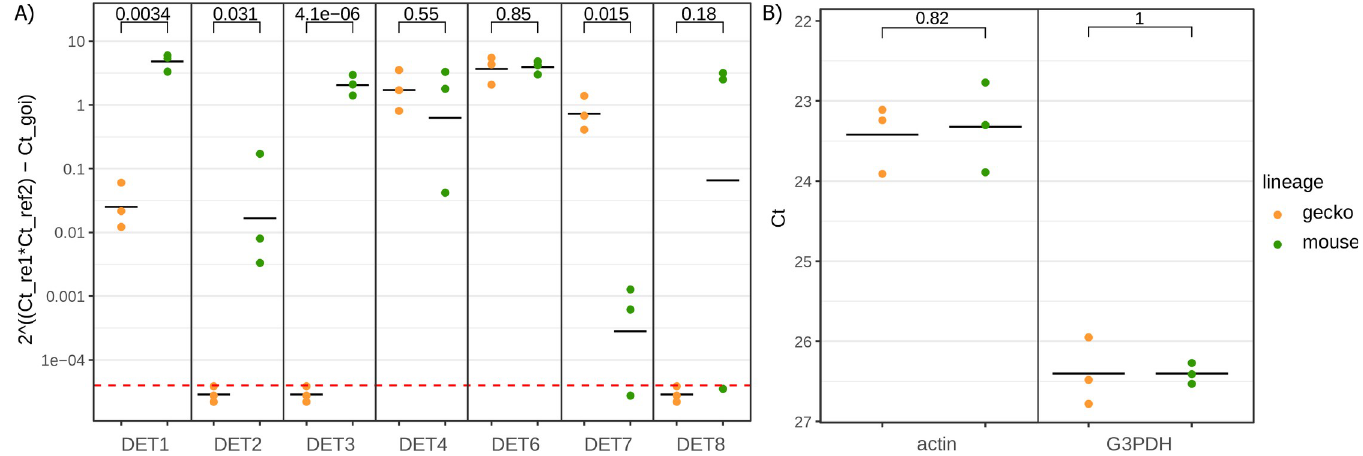
Fig 10. Differential gene expression in S . schwetzi lineages feeding on mice (S-M) and geckos (S-G). Differential expression of seven transcripts was evaluated by RT- qPCR method. (A) The obtained C T values were relatively quantified according to the 2 - ΔΔ CT method [45] using actin and G3PDH as the reference transcripts. The relative gene expression values of all samples were calibrated to mean of C T values measured for each transcript from S-G lineage. Each column of chart contains relative expression of one differential expressed transcript (DET1–8) for both S-G (orange points) and S-M (green points) cDNA, measured in three independent replicates. The mean of relatively quantified values is depicted by horizontal line in black color. The expression values below the red line were under the detection RT-qPCR limit (C T = 40). The expression difference between S-G and S-M were compared by t-test and p-values are shown above the square bracket. (B) The C T values for the reference transcripts (actin and G3PDH) for both S-G (orange points) and S-M (green points) cDNA, measured in three independent replicates.